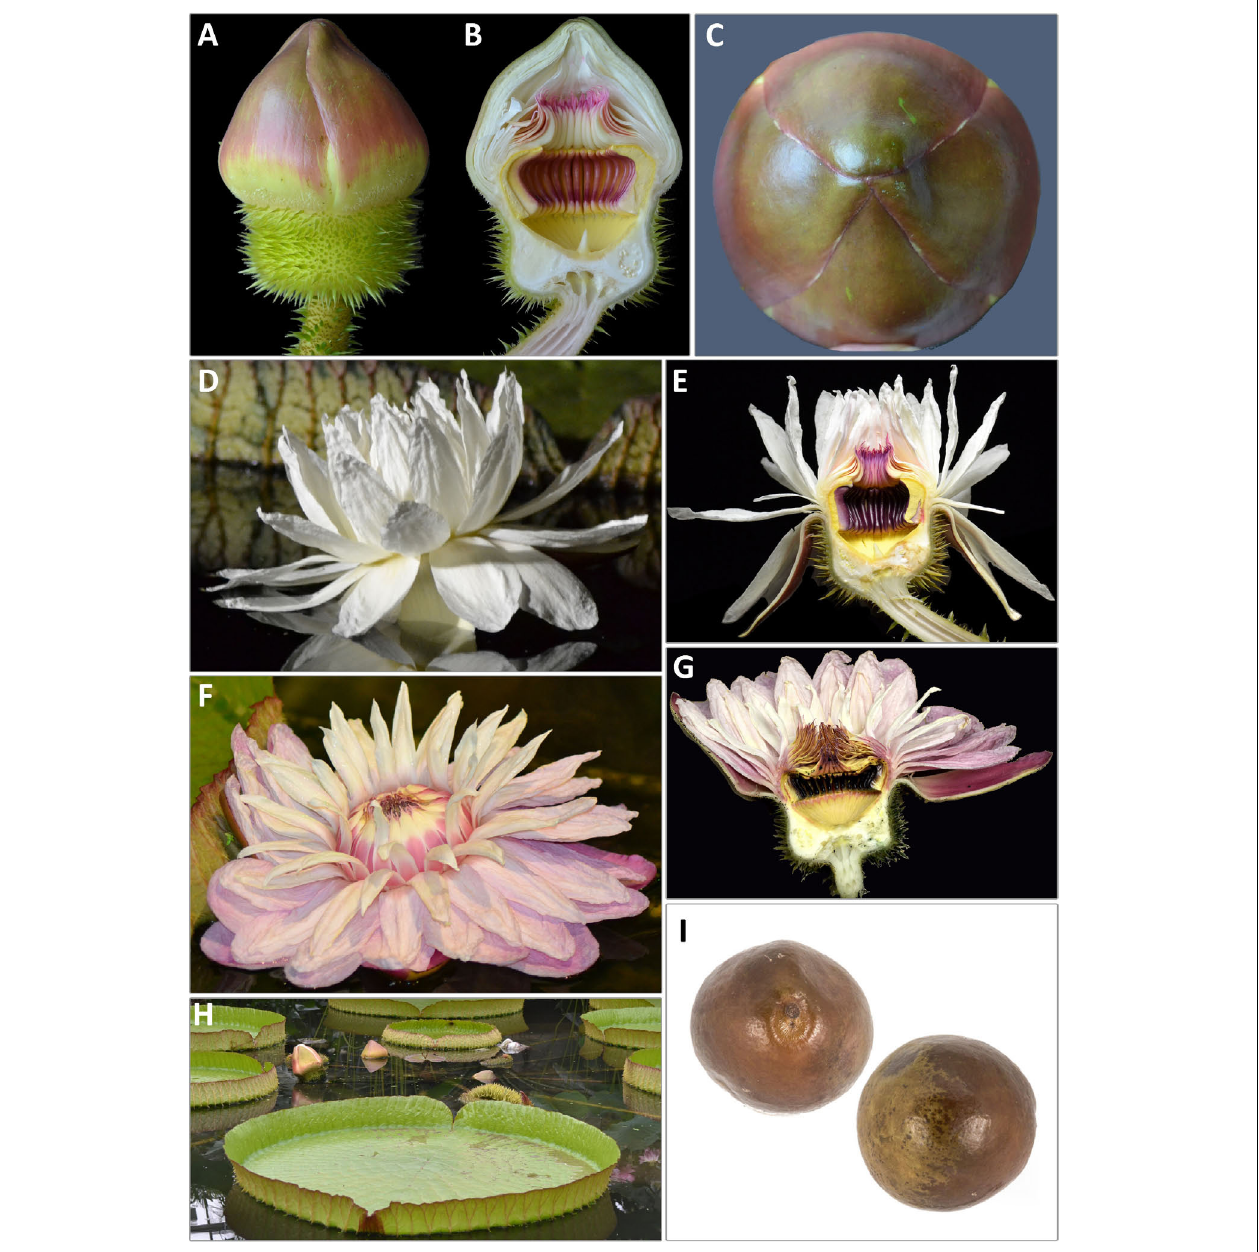
FIGURE 11 | Victoria cruziana (A) bud whole, (B) bud L.S., (C) bud from above, (D) first night flower, (E) first night flower L.S., (F) second night flower, (G) second night flower LTS, (H) habit, and (I) seed. (A–D,F,G) (photo LTS), (I) (CM) cultivated RBG Kew, (D,E) cultivated Denver Botanic Gardens (LTS).